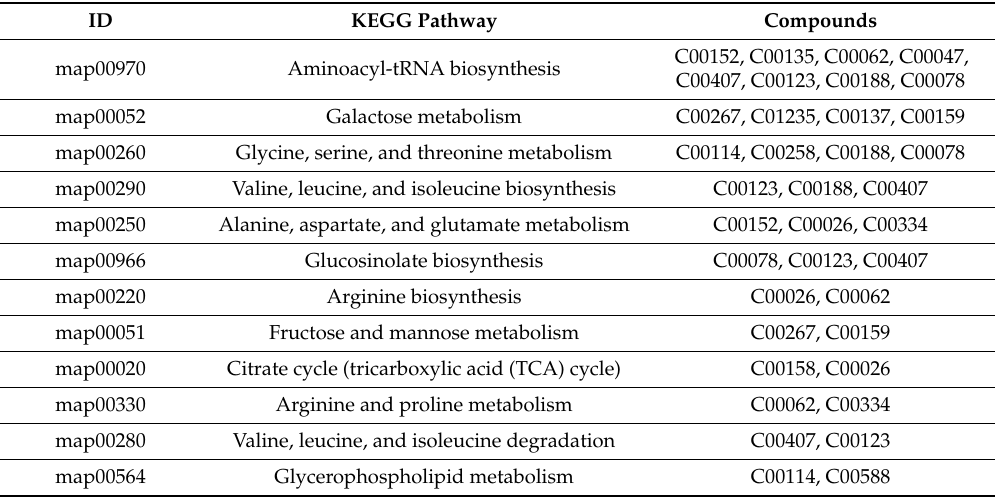
Table 3. KEGG pathways including more than ≥ 2 significantly changed metabolites a ff ected by